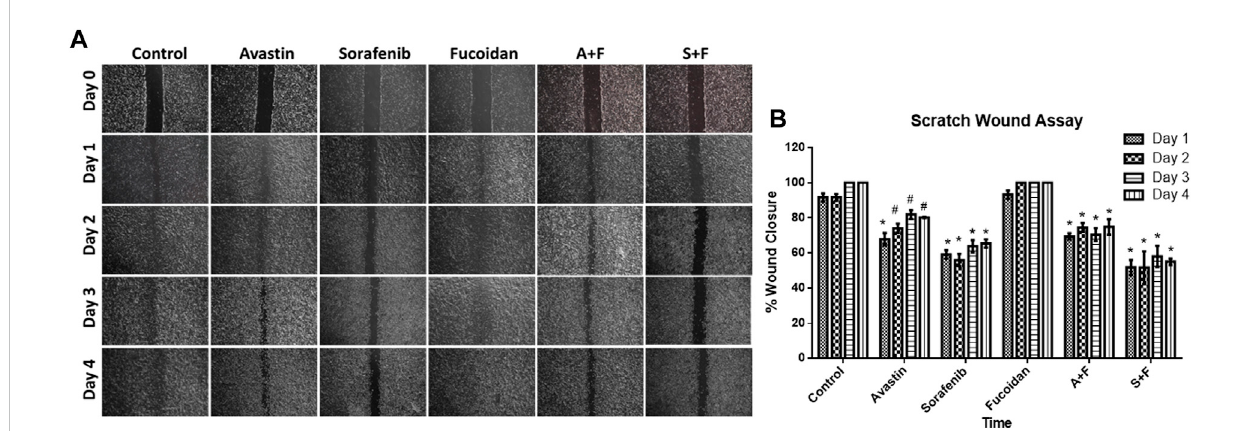
FIGURE 4 Annexin V/PI apoptosis assay showingtheeffect ofAvastin, sorafenib, fucoidan monotherapies orincombinationon thepercentage of apoptosis in HUH-7cells (A) DotplotsofAnnexinV-FITC versus PIsignaldetected(representativedataisshown). (B) Stackedbarchartshowingthepercentageofcells detected in each quadrant. 98.1% and 97.66% of the cell population was alive in the untreated control and Avastin with no signi fi cant difference between both groups. Sorafenib monotherapy caused a signi fi cant increase in the percentage of cells in late apoptosis (0.52%) and necrosis (6.6%) and a signi fi cant decrease in the percentage of live cells (92.8%) compared to untreated control. Fucoidan, A + F and S + F showed similar patterns with a signi fi cant decrease in live cells to 91.6%, 94.66% and 92.83%, respectively, with an increase of necrotic cells to 8.3%, 4.4% and 6.9%, respectively compared to untreated control. A + F was signi fi cantly better than Avastin monotherapy as higher percentage of cells were detected in early apoptosis and necrosis. While theS + F combination showed very similar fi ndings to sorafenib monotherapy (n = 3wells/treatment, *** p < 0.0001 versus untreated control and $ p < 0.0001 compared to monotherapy, one-way ANOVA, Tukey ’ s post hoc